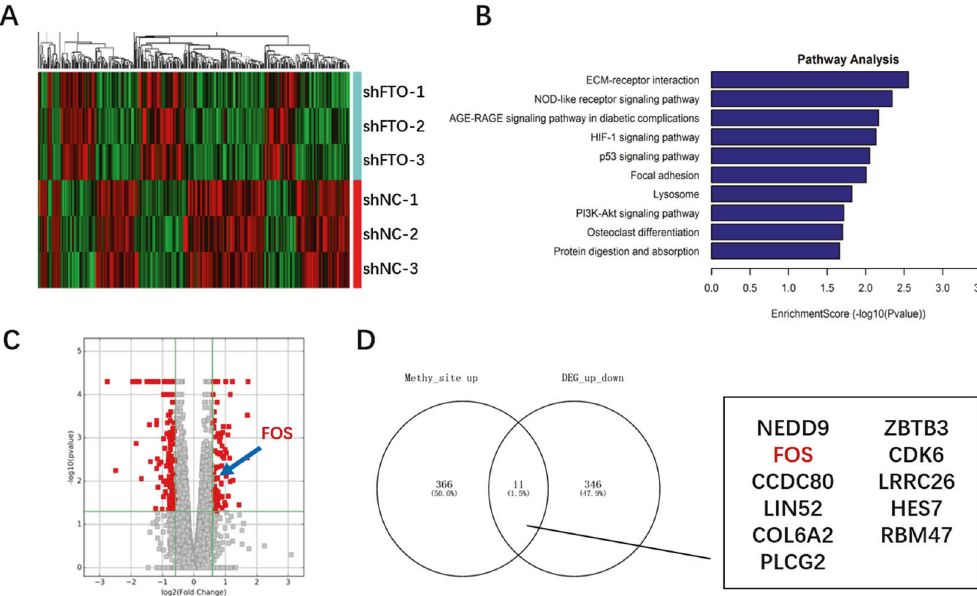
Fig. 2 MeRIP-seq and mRNA-seq of COV434-shFTO and COV434-shNC. A Clustered heat map of the differentially expressed mRNAs in COV434-shFTO (shFTO1-3) and COV434-shNC (shNC1-3) cells. Rows represent cells while columns represent mRNAs. B GO analysis of differentially expressed mRNAs in COV434-shFTO and COV434-shNC. C Volcano plot showing differentially expressed mRNAs between COV434-shFTO and COV434-shNC in red dots. FOS is indicated by arrows (fold change >2.0 and P < 0.01). D Venn diagram illustrating